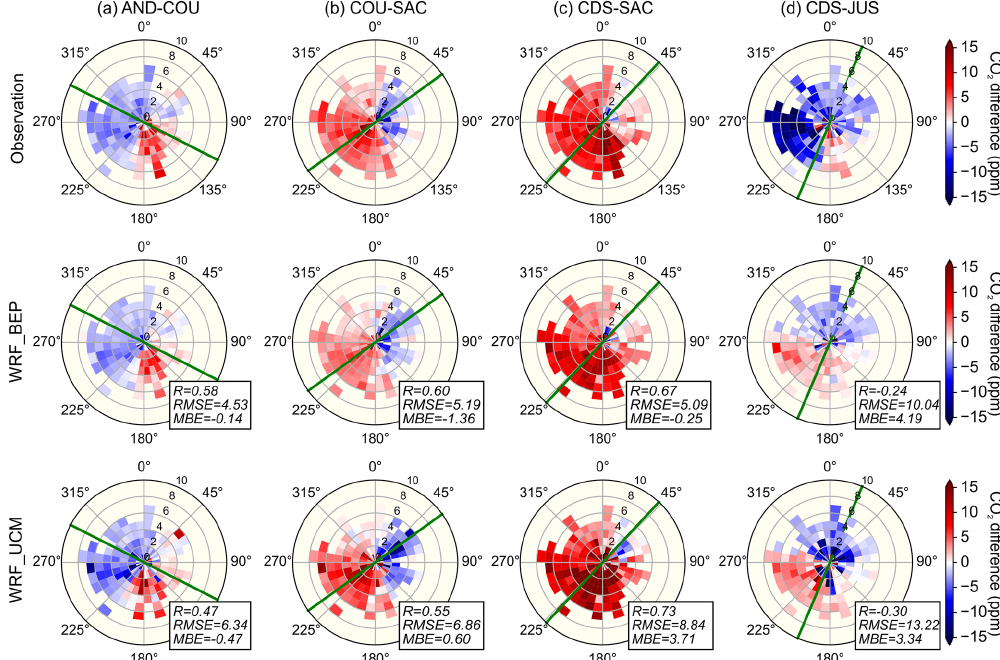
Figure 5. Spatial differences in CO 2 concentration between two stations of the in situ network, averaged over sets of situation corresponding to bins of wind speed and direction. Only the afternoon (11:00–16:00UTC) data are used. The top row shows the observations, whereas the other two rows show the two simulations (UCM, BEP). The green line indicates the direction defined by two in situ stations. The statistics of hourly values of observed and modeled CO 2 concentration differences are shown in the